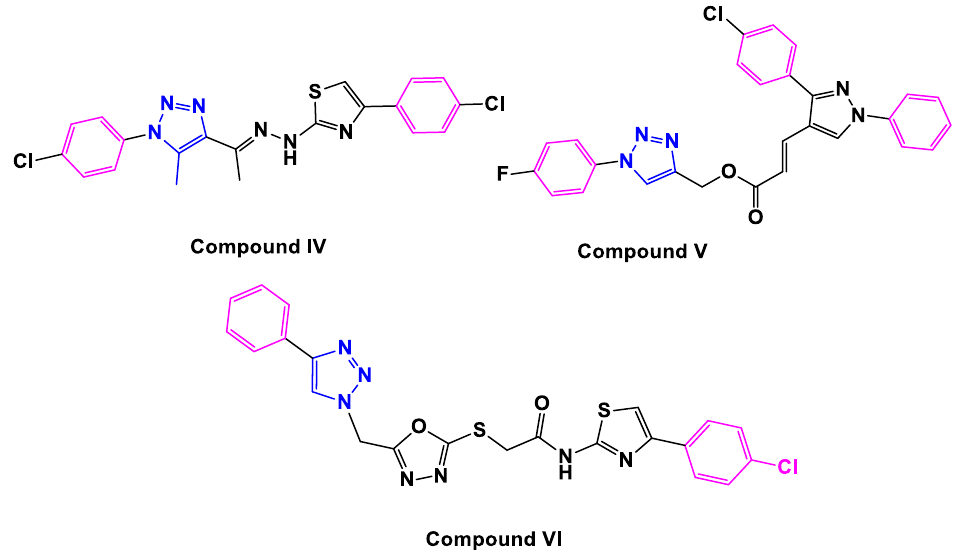
Figure 2. Structure of 1,2,3-triazole-based apoptotic anti-cancer agents IV – VI.